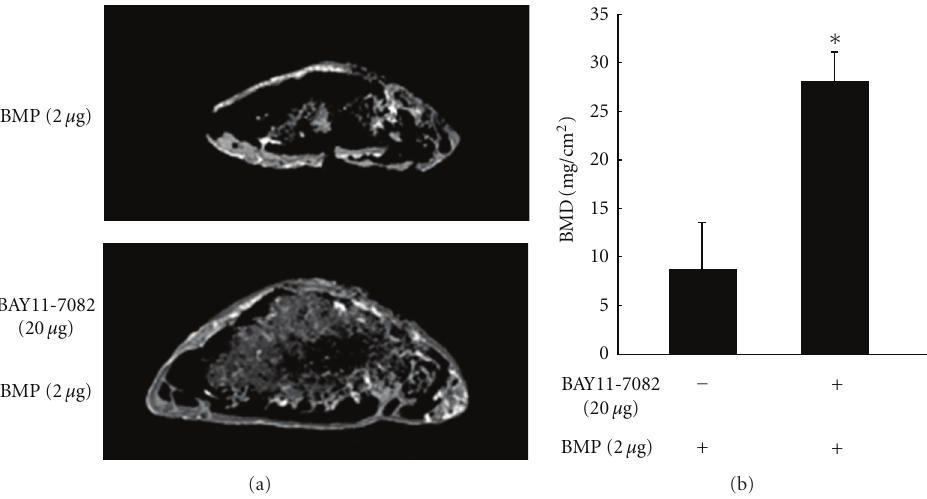
Figure 4: BMP2-induced ectopic bone formation in vivo is enhanced in the presence of a selective inhibitor of NF- κ B, BAY11-7082. Two micrograms of BMP2 was implanted subcutaneously to induce ectopic bone formation in the presence or absence of BAY11-7082 in mice ( n = 8). (a) μ CT reconstruction images of ectopic bone in the presence or absence of BAY11-7082 in mice. Bar: 1mm. (b) Bone mineral density (BMD) of the ectopic bone in the presence or absence of BAY11-7082 was measured by dual-energy X-ray absorptiometry (DXA). ∗ P < 0 .